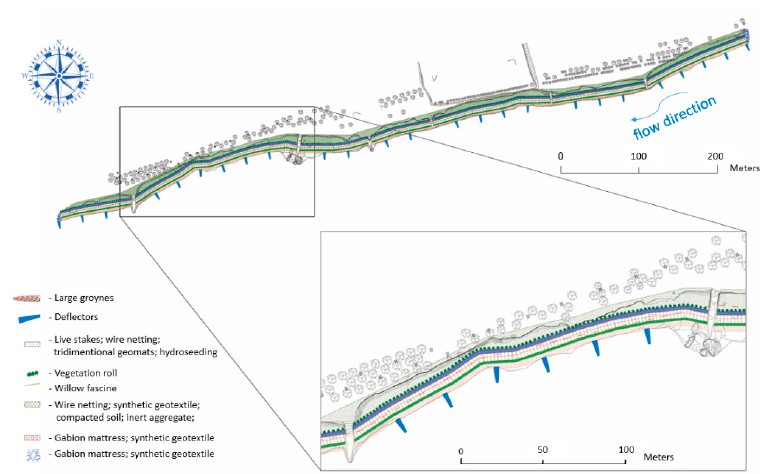
Figure 3. General view of the intervention area at the Cardielos site.